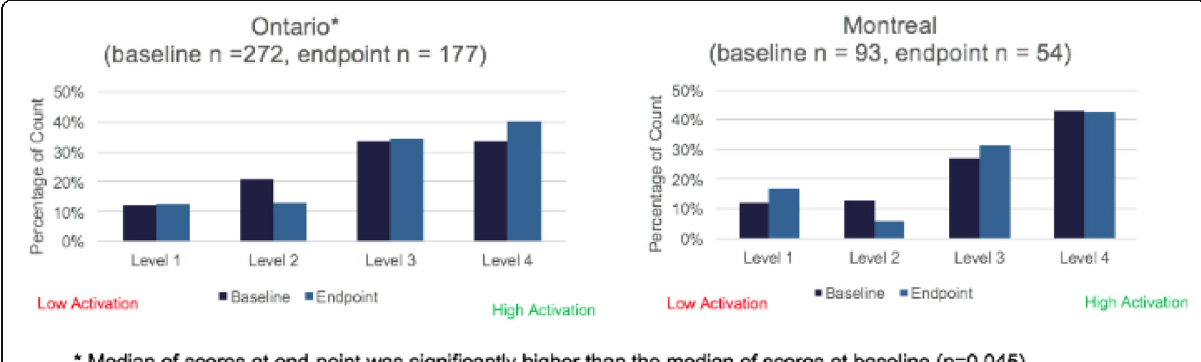
Fig. 4 Pre/Post Patient Activation Scores for Disease Sites Combined for Ontario and Montreal